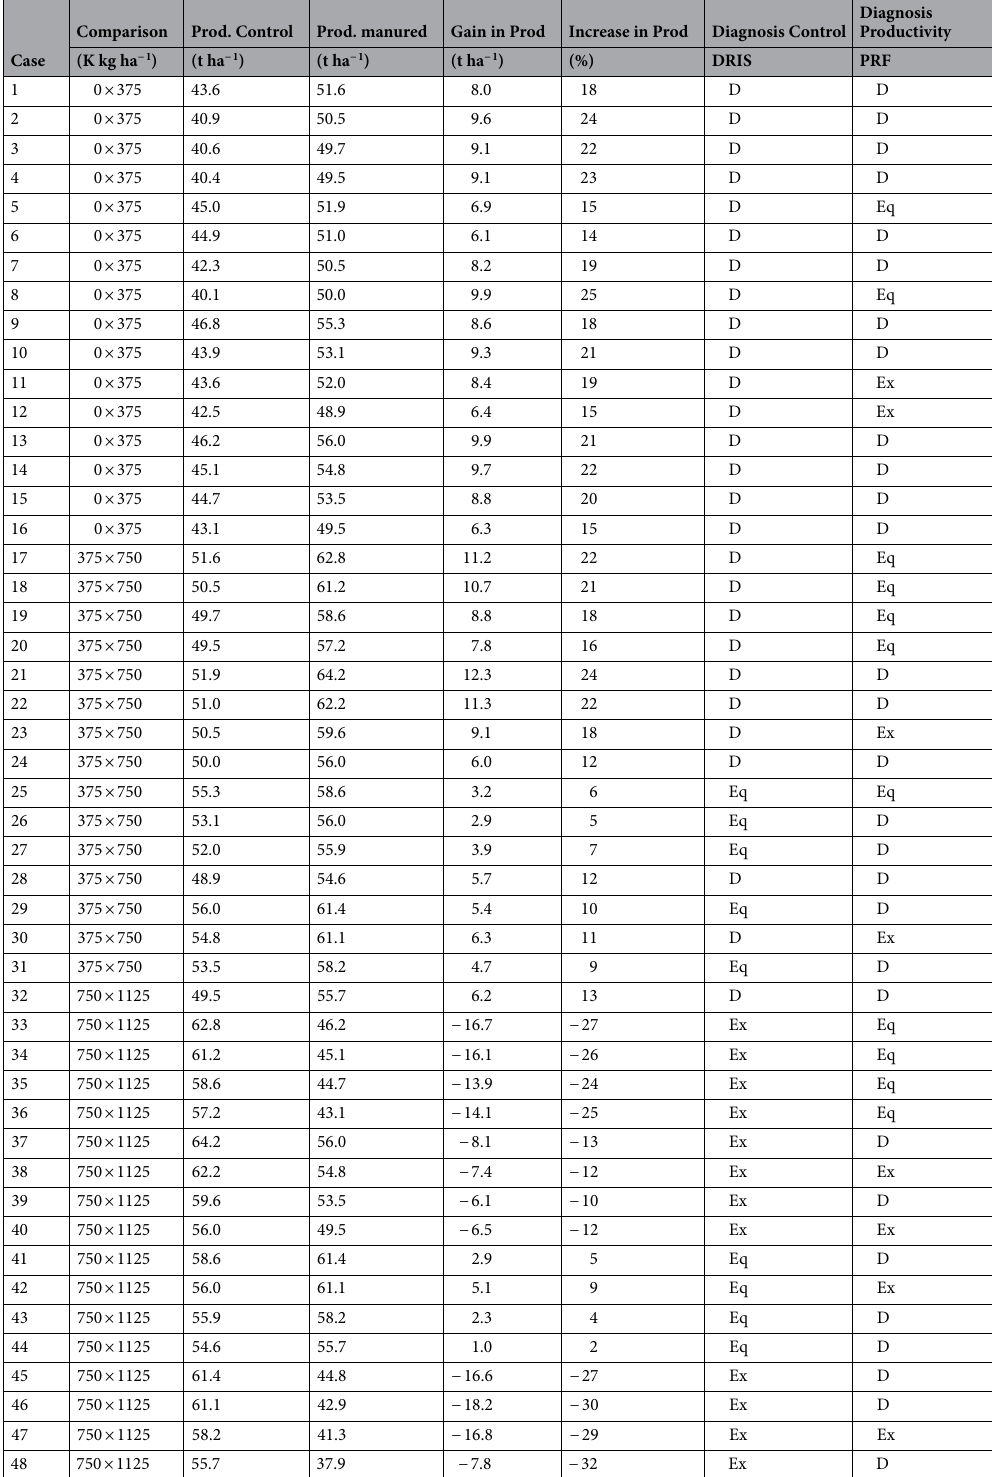
Table 4. Accuracy of nutritional diagnosis for the nutrient K for DRIS norms in banana ( Mussa spp.). K potassium dose, Prod average productivity, Eq nutritional equilibrium, D nutritional deficiency, Ex nutritional excess, PRF potential response to